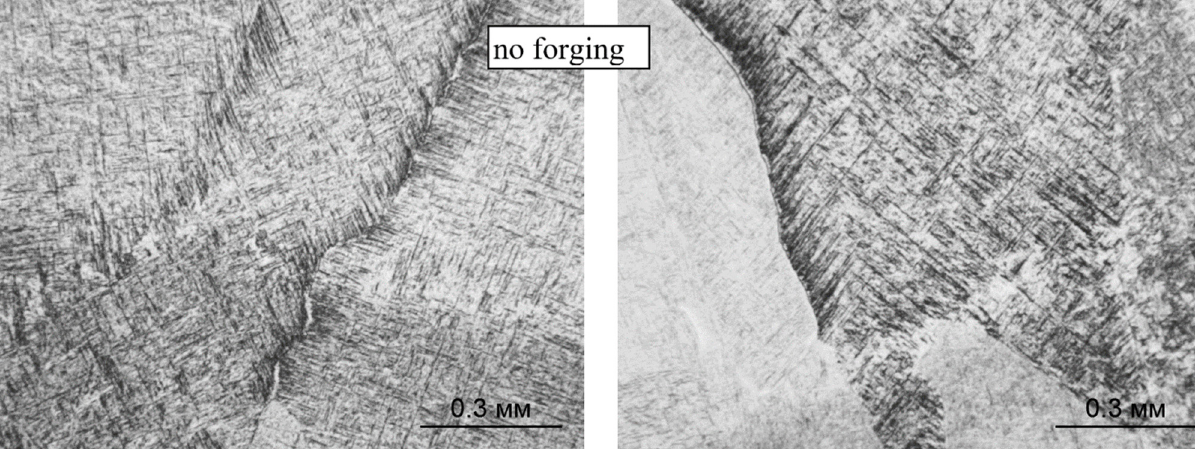
Figure 8. Boundaries between the deposited layers in the structure of the metal CMT deposition without forging; ×100.